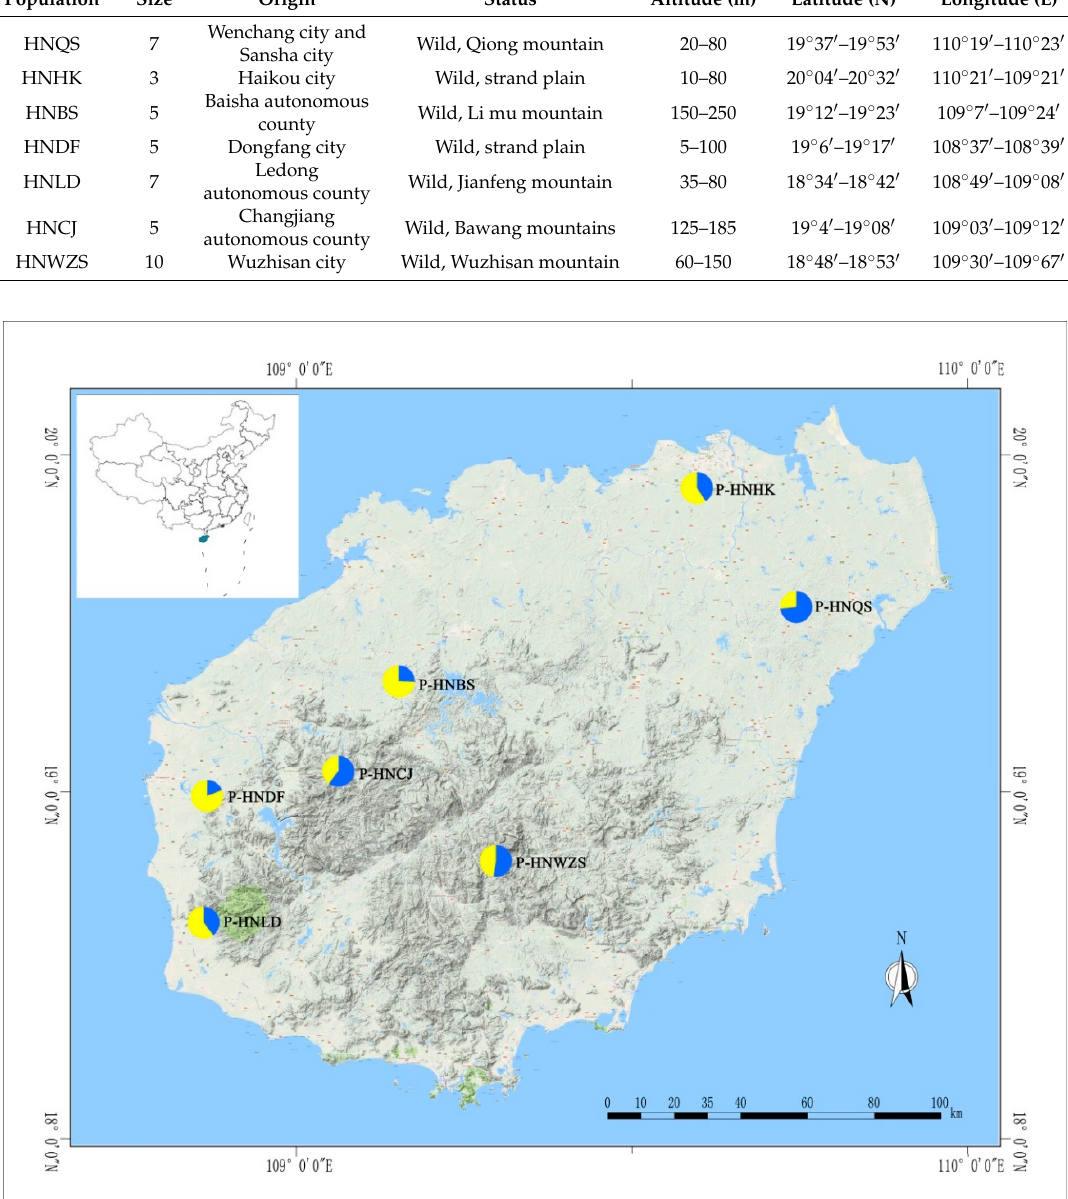
Table 1. Geographical location of seven investigated D. odorifera populations in Hainan Island of China.